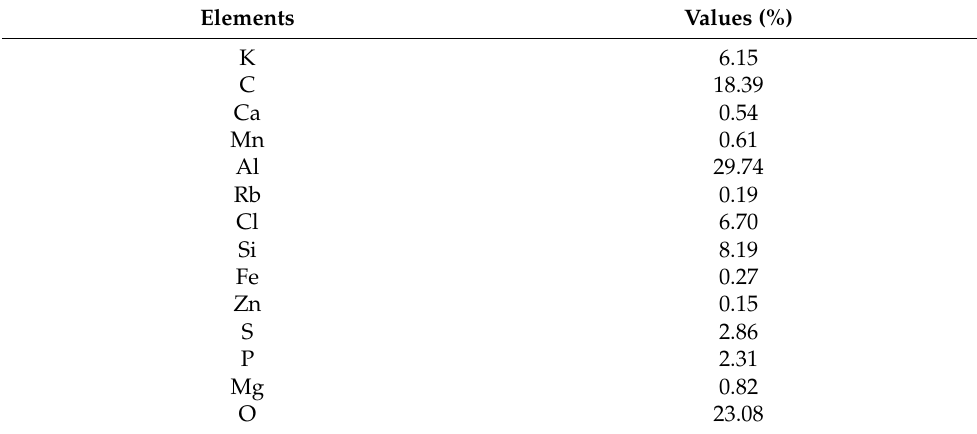
Table 3. Elemental analysis of ASMF-C.